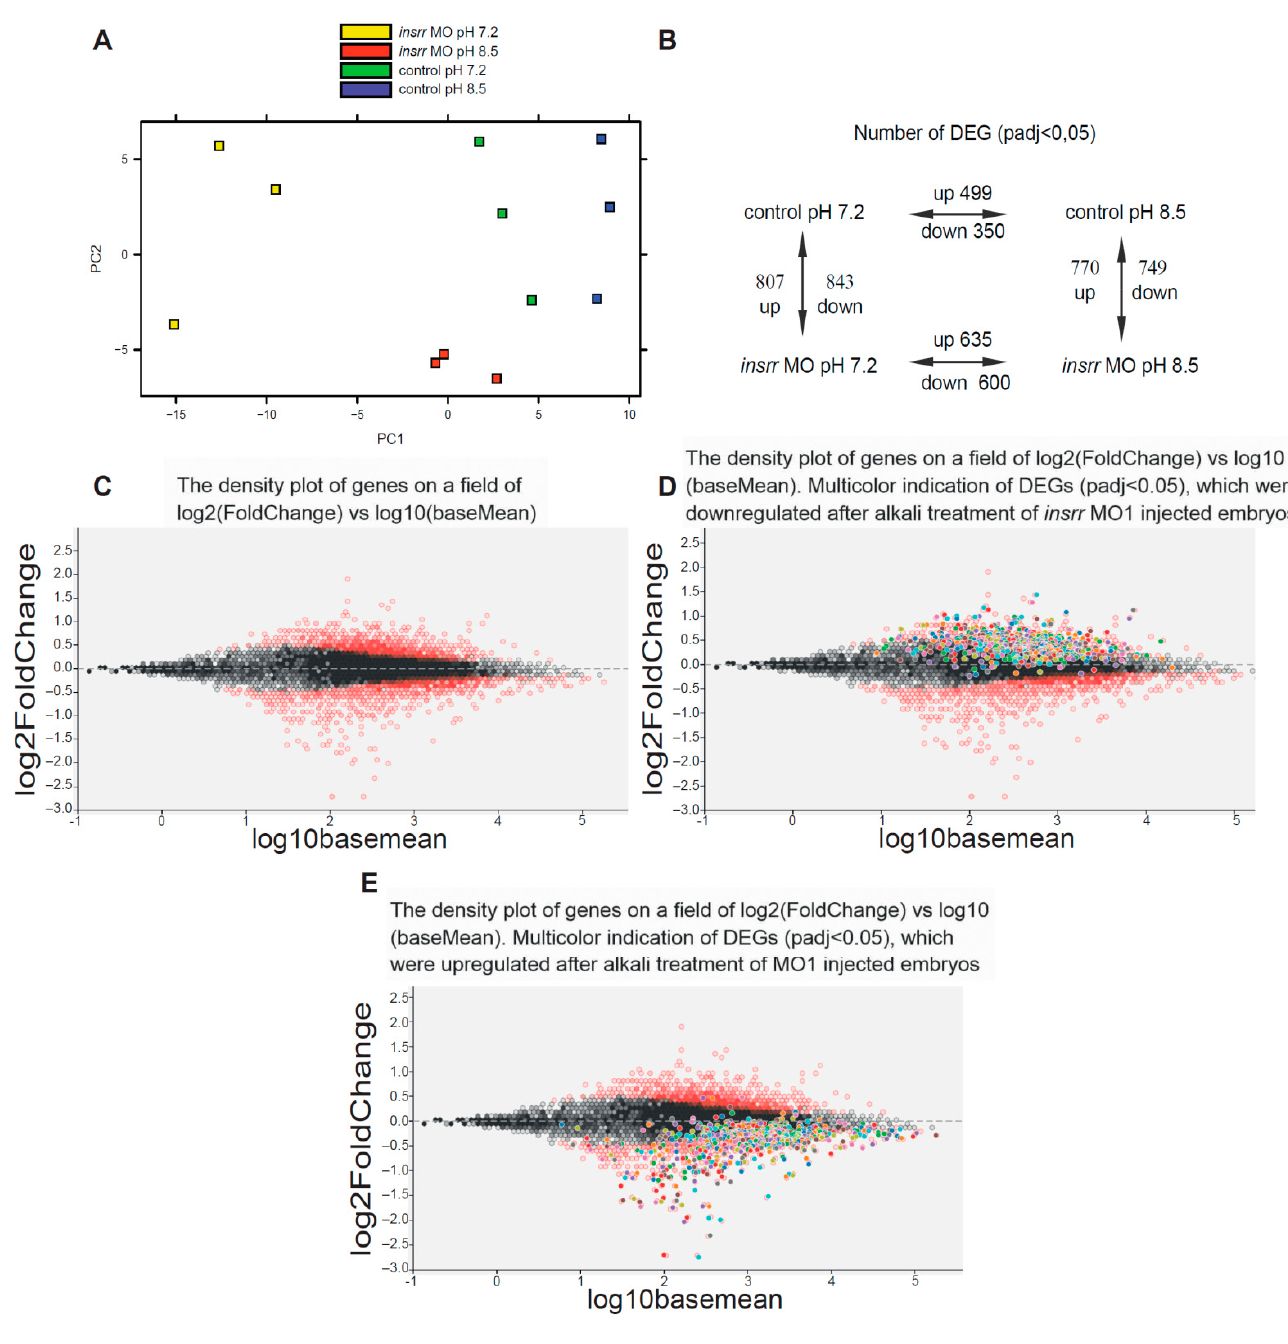
Figure 2. ( A ). PCA analysis of RNA-seq data of control embryos and insrr MO1 knockdown embryos after incubation in pH 7.2 or 8.5 media. ( B ). Representation of upregulated and downregulated DEGs (padj < 0.05) of control embryos and insrr MO1 knockdown embryos after incubation in pH 7.2 or 8.5 media. ( C ). The density plot of genes on a field of log2(FoldChange) vs. log10(baseMean) was plotted after differential expression analysis of transcriptomes between control and insrr MO1 knockdown embryos. DEGs with padj < 0.05 are colored in red and other genes are colored in grey. ( D ). Same plot with multicolor indication of DEGs (padj < 0.05) which were downregulated after alkali treatment of insrr MO1-injected embryos. ( E ). Same plot with multicolor indication of DEGs (padj < 0.05), which were upregulated after alkali treatment of insrr MO1-injected embryos.